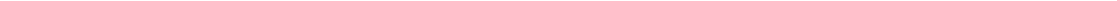
Fig. 6 In networks, dLTP can protect previously learnt connections. a Top : A neuron model with simpli fi ed dendrites is implemented for the network simulations. The model consists of two compartments per dendrite, one representing a proximal compartment and one representing a distal compartment (see also Supplementary Fig. 5). Bottom : A network represents an associative memory ( “ coffee ” ), containing four subgroups of neurons which we will call “ features ” , in this case they are colour (brown), something you like, hot and drink. The initial weights are all-to-all and initiated at the maximum bound. b When randomly activating the individual features, the distal synaptic clusters are always activated together and evoke NMDA spikes. While proximal weights between features depress, distal weights remain close to the initial value. c The fi nal synaptic weight matrix corresponding to panel b . d A second network consists of two associative memories, “ chocolate ” and “ coffee ” . Each association is composed of four features. The associations share two features ( “ Colour ” and “ Like ” ), the connectivity is all-to-all and all weights are initialised at the lower bound. e – g During the fi rst 100 s, the “ chocolate ” association is activated ten times more frequently than the “ coffee ” association. Proximal and distal synaptic weights between neurons of the “ chocolate ” association are strengthened e , f . From 100 to 200 s, we reverse the activation probability: the “ coffee ” association is presented ten times more frequently. The synaptic weights between neurons of this association are now maintained or strengthened e , g . The proximal synapses towards features that are exclusively part of the “ chocolate ” association are now weakened, while the corresponding distal synapses remain more stable f . During the fi nal 100 s, the same protocol as in the initial 100 s is followed, activating mostly “ chocolate ” association. The proximal synapses towards features that are exclusively part of the “ coffee ” association are now weakened, while the corresponding distal synapses remain more stable g . h , i Weight matrix after 200 s ( h and asterisk in e – g ) and 300 s ( i and triangle in e – g ) of the simulation. Notice the difference in the proximal weights (left panels) from features “ Like ” and “ Colour ” to features “ Sweet ” , ” Food ” , ” Hot ” and “ Drink ” . The distal weights (right panels) remain